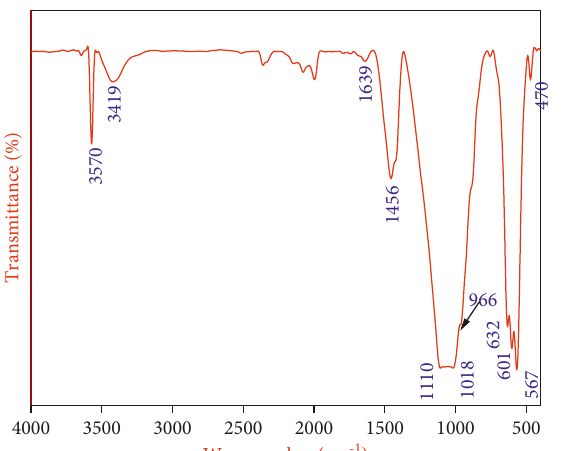
Figure 10: FTIR spectroscopy-coated titanium.